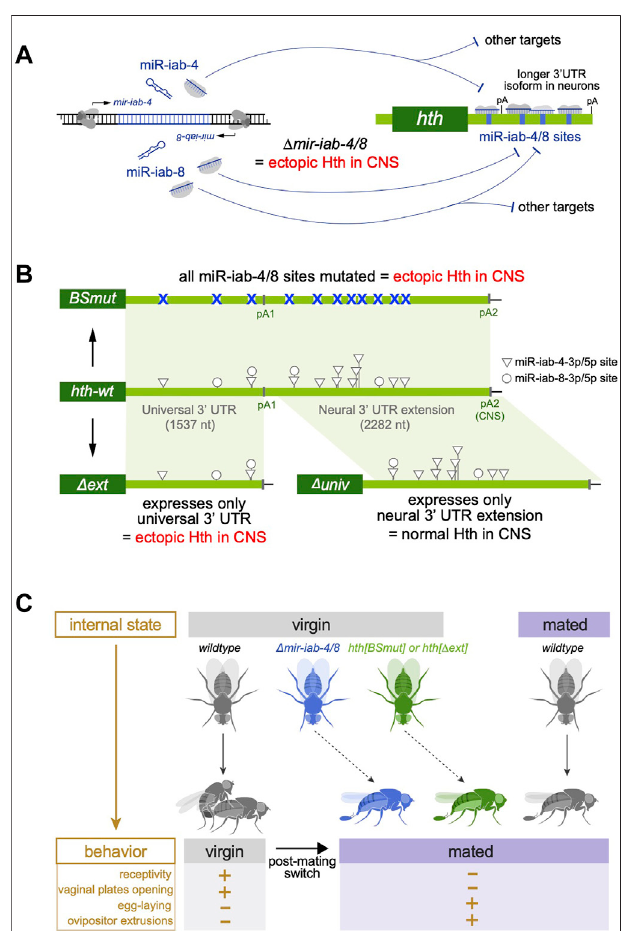
FIGURE 4 | Biological impact of neural polyadenylation on development and behavior. (A) An individual hairpin locus in the Drosophila Bithorax Complex is bidirectionally transcribed to generate distinct miRNAs (miR-iab-4 and miR-iab-8) that are expressed in speci fi c domains of the central nervous system (CNS). One of the major targets of these miRNAs in homothorax ( hth ),whichcontainsnumerousconservedbindingsitesforthese miRNAs. hth is broadly expressed but undergoes 3 ’ UTR lengthening in the CNS, creating a scenario for enhanced miRNA targeting in this setting. Expression of the hth 3 ’ UTR extension is lost in elav/fne mutants, and Hth protein is ectopically expressed in the CNS of miRNA deletion fl ies. (B) Targeted genetic manipulation of the endogenous hth 3 ’ UTR creates alleles bearing point mutations in all of the miR-iab-4/8 sites, or that delete either the proximal (universal) hth 3 ’ UTR or the extended 3 ’ UTR expressed in the nervous system. Both the hth[BSmut] and hth[ Δ ext] alleles derepress Hth in the CNS, but the hth[ Δ univ] allele has normal Hth. (C) Behavioral assays demonstrate that dual regulation of hth by miR-iab-4/8 and neural alternative polyadenylation is required to match the behavior of virgin females with their internal state. In wildtype, virgin females are sexually receptive and tend not to lay eggs, but after mating, females oppose male courtship and increase egg laying. Virgin females of Δ mir-iab-4/8 , hth[BSmut] , and hth[ Δ ext] genotypes all exhibit mated-like